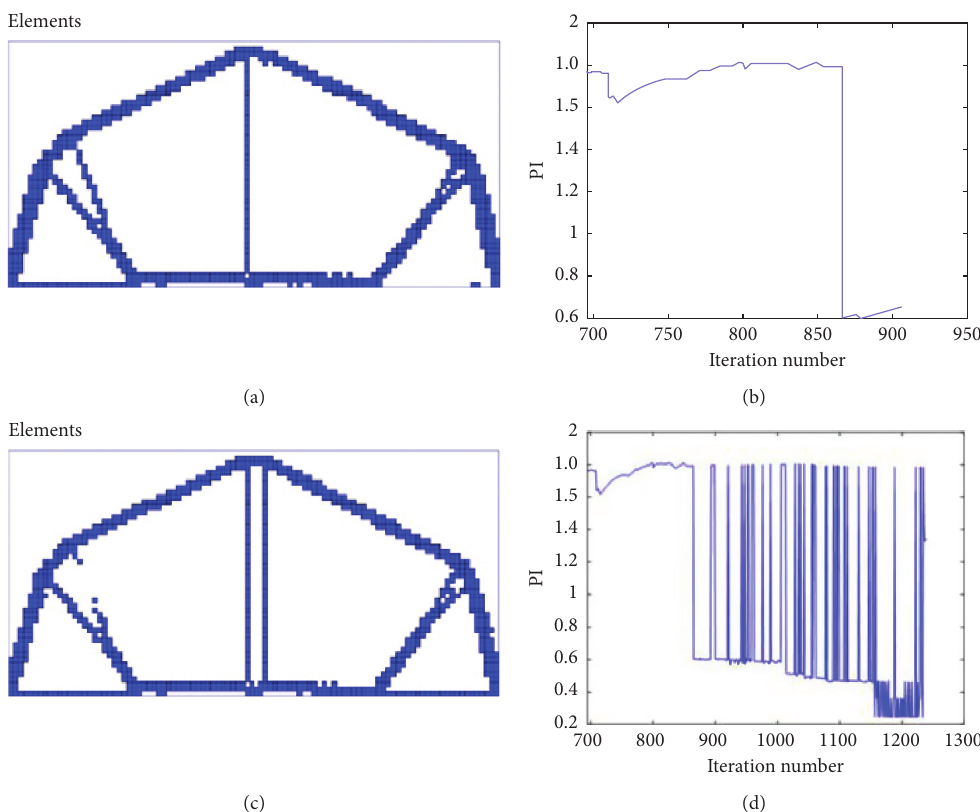
Figure 6: Comparison of the topology for 85% volume reduction by IGESO and GESO: (a) topology by GESO, (b) PI curve of GESO after 700 iterations, (c) topology by IGESO, and (d) PI curve of IGESO after 700